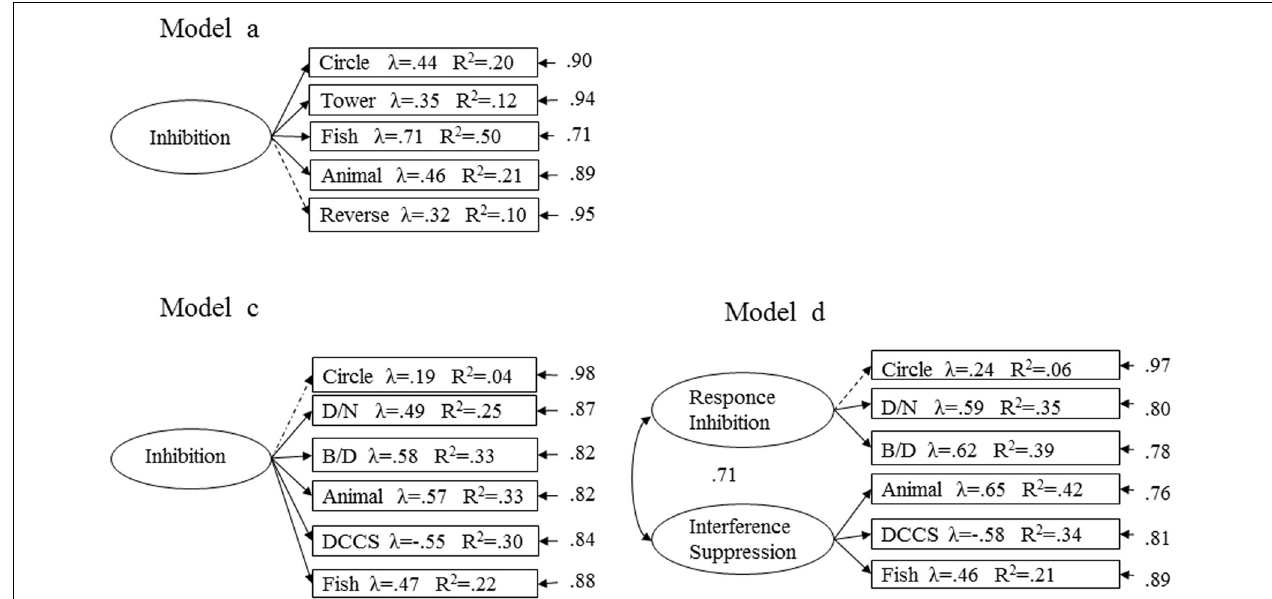
FIGURE 2 | Standardized factor loadings, R 2 values and error terms are shown for unitary and two factor models for both age groups: model a for youngest children and model c and model d for oldest children. The standardized factor loadings and the R 2 values are reported into the box for each observed variable. The error terms are shown near the observed variables at the end of the smaller, single-headed arrows.